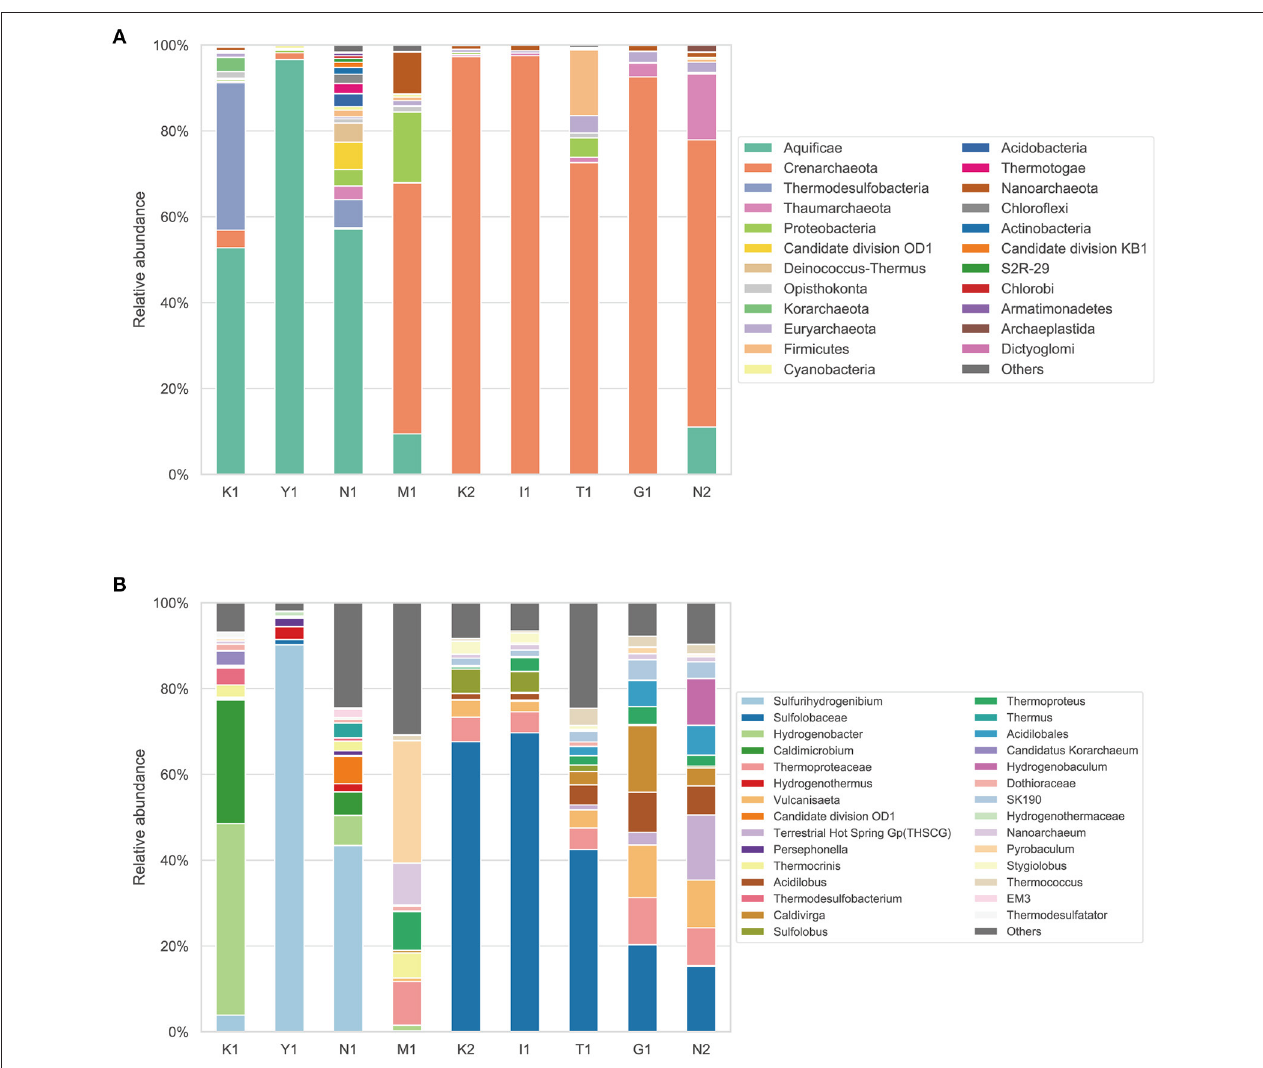
FIGURE 2 | Taxonomic composition and relative abundance of microbiota in water from Kirishima hot springs based on 16S rRNA genes identified from the metagenomic reads. (A) Taxonomic composition of the microbiota at phylum level. (B) Detailed taxonomic composition (i.e., genus, family or order) of the